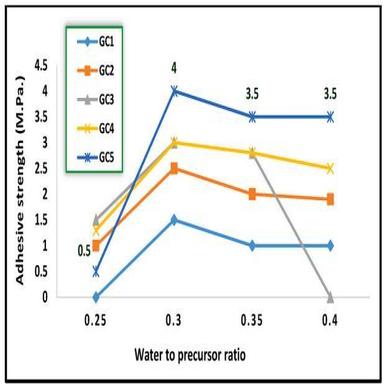
Adhesion strength of hybrid geopolymeric samples acquired at different water to precursor ratio.